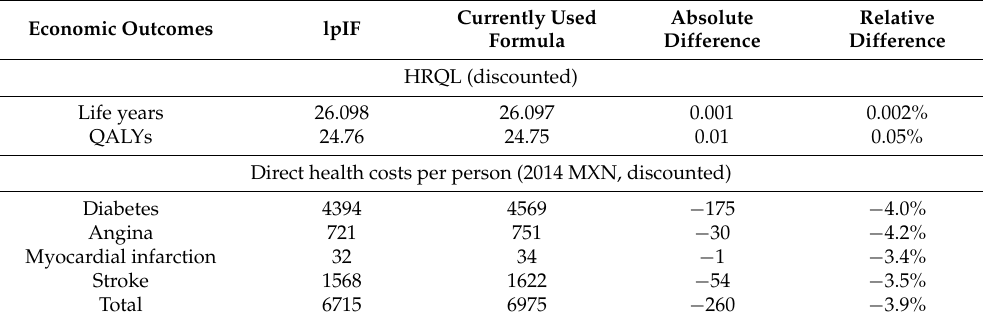
Table 4. Base-case economic